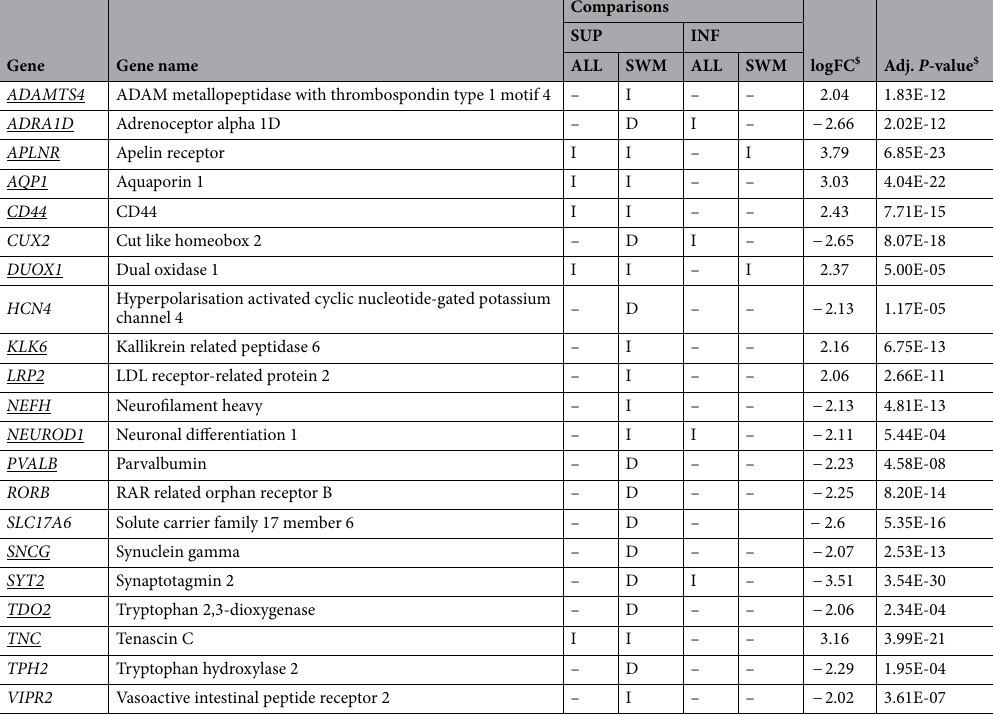
Table 2. Protein-coding brain layer associated DEG in AD in SUP versus INF layers. I: increased in the first term of the comparison; D: decreased in the first term of the comparison; -: unchanged. Underline genes were also repeatedly associated with AD. $ : values referent to the comparison between SUP and